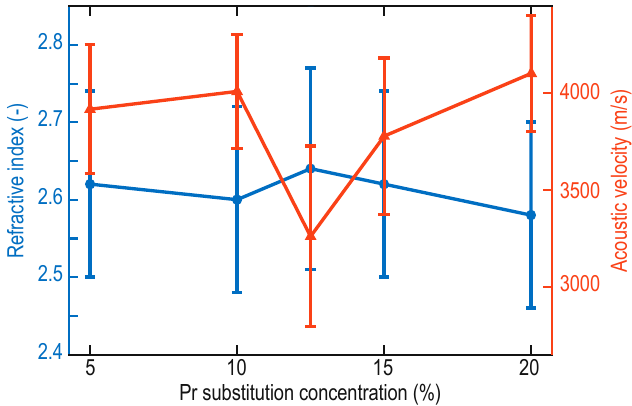
Figure 8. Dependencies of the optical refractive index and the longitudinal sound velocity on the Praseodymium substitution concentration in (Bi 1 − x Pr x )(Fe 0.95 Mn 0.05 )O 3 films deposited on LAO substrate.